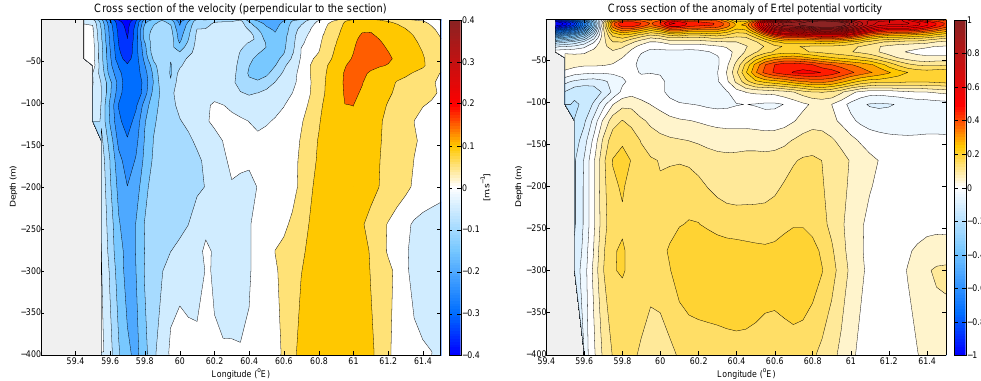
Figure 6. Section across the coastal current during the winter monsoon (from HYCOM): (left) velocities across the section (positive toward the northeast); (right) anomaly of Ertel potential vorticity. A vertical influence of the surface structures is observable. An inversion of the Ertel potential vorticity sign occurs between the surface and